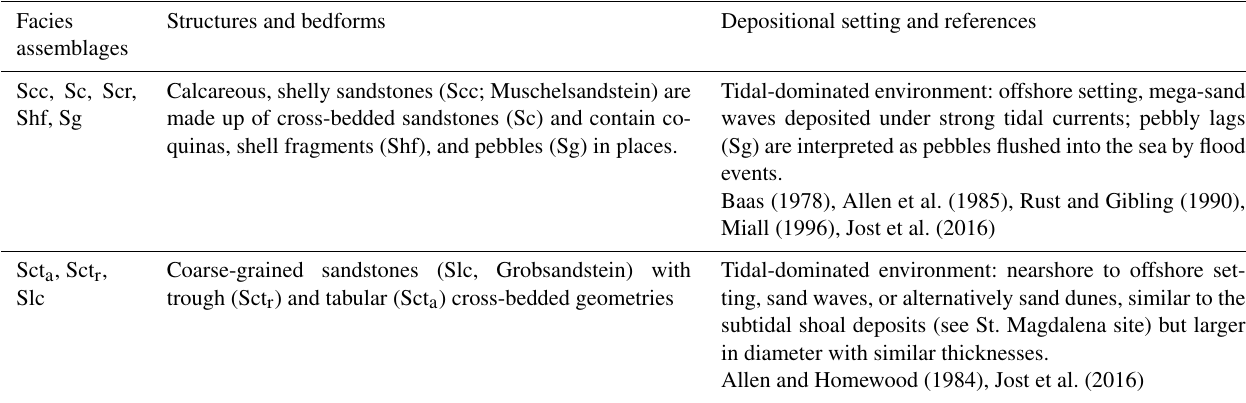
Table 5. Lithofacies encountered in the Lake Neuchâtel and Wohlen areas. Facies Structures and bedforms Depositional setting and assemblages